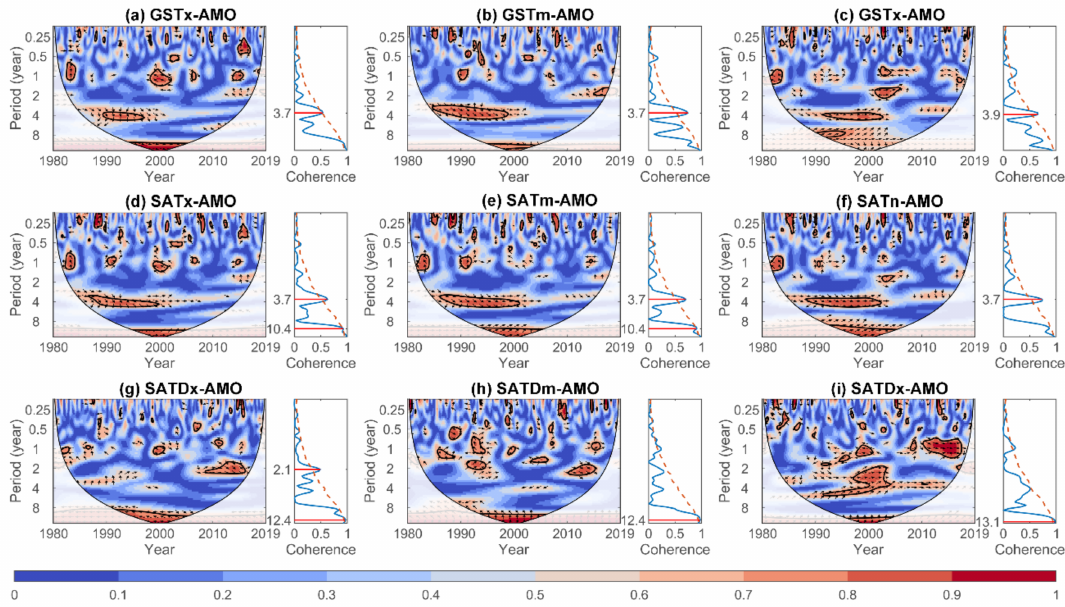
Figure 8. Wavelet transform and global coherence of anomaly of the monthly averaged ( a – c ) GST-, ( d – f ) SAT-, and ( g – i ) SATD-related indexes with the highest PASC large-scale index from 1980 to 2019 in Southwest China (Red dotted line in global coherence represents significant at 0.05